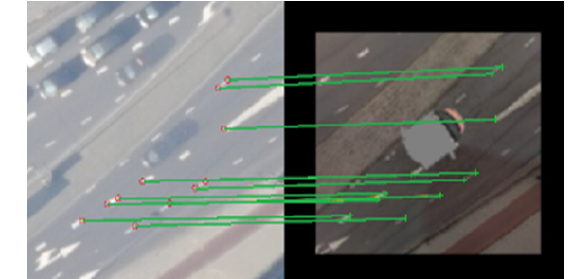
Figure 11 Förstner Cross-Correlation matching result of 6 th